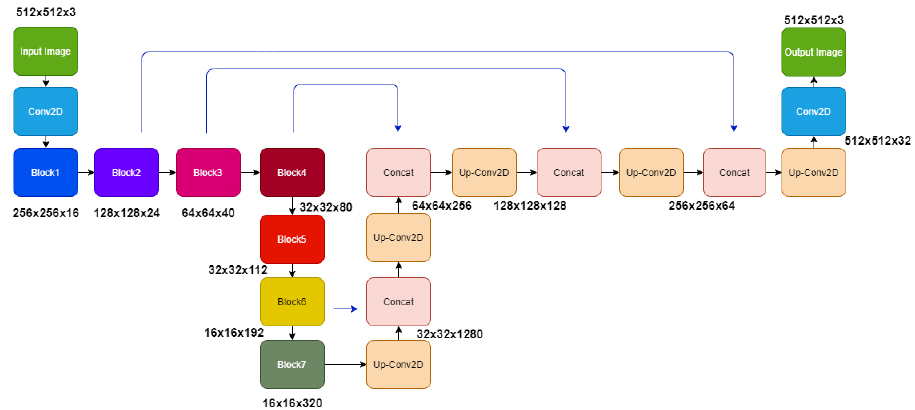
Figure 3. Architecture of EfficientNetB1 with MBConv as basic building blocks. The overall archi- tecture can be divided into seven blocks, as shown. Each MBConvX block is shown with the corre- sponding filter size.